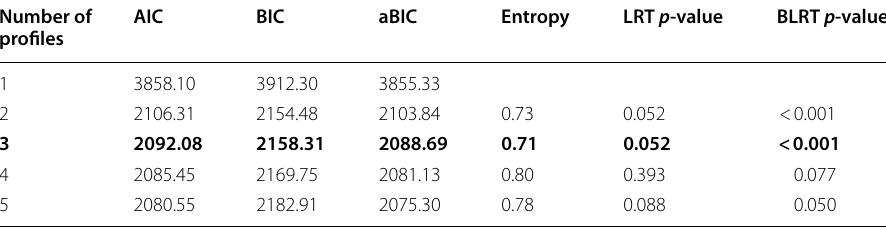
Chosen solution is highlighted in bold